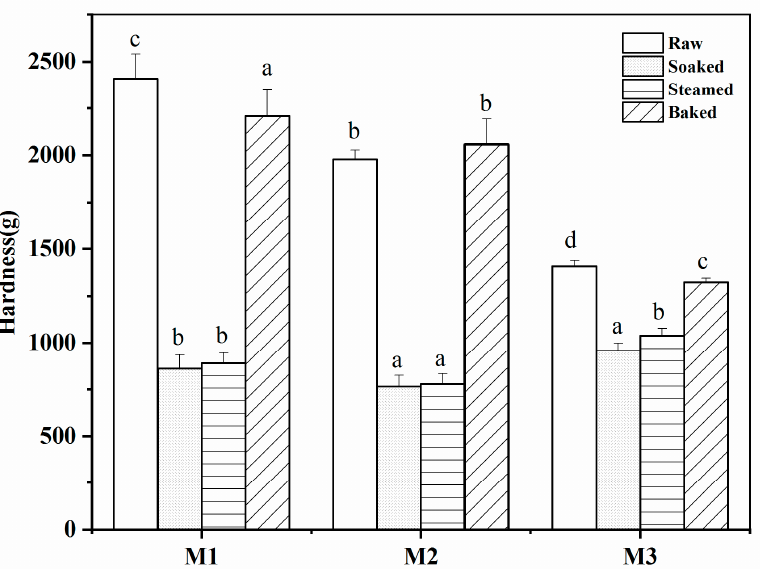
Figure 5. The hardness of raw and different processed millet grains. Columns with different letters for hardness for each millet are significantly different with p < 0.05.